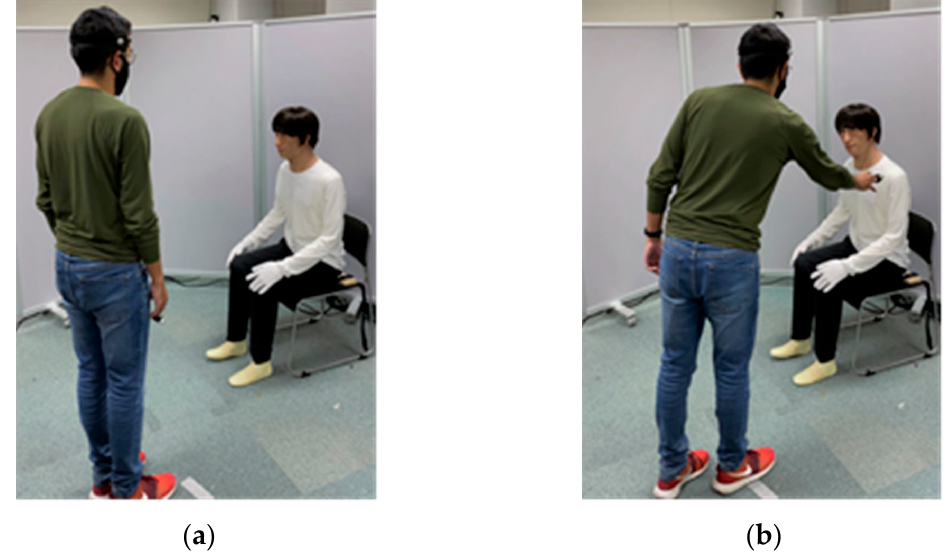
Figure 1. Android behavior to participant’s approach: ( a ) initial position for starting touch interaction; ( b ) android looking at participant at a certain distance before being touched.